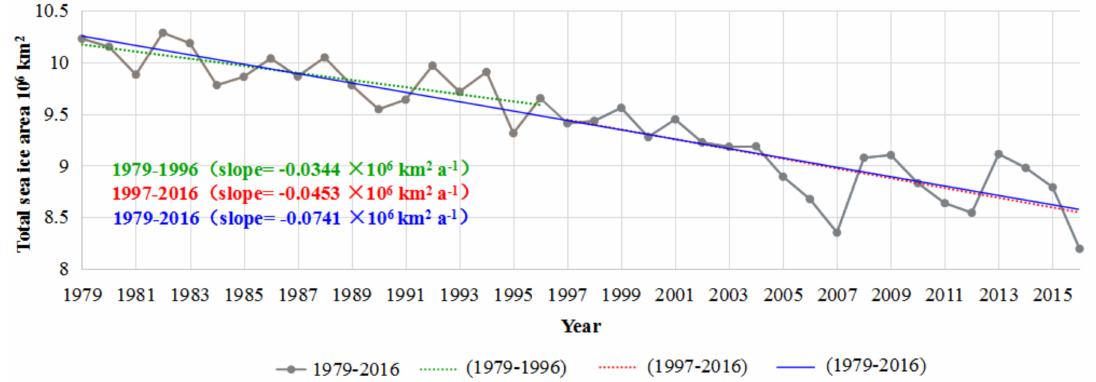
Figure 2. The variation of Arctic SIA from 1979–2016. (Grey solid line: 1979–2016 yearly data; blue solid line: 1979–2016 trend; green dashed line: 1979–1996 trend; red dashed line: 1997–2016